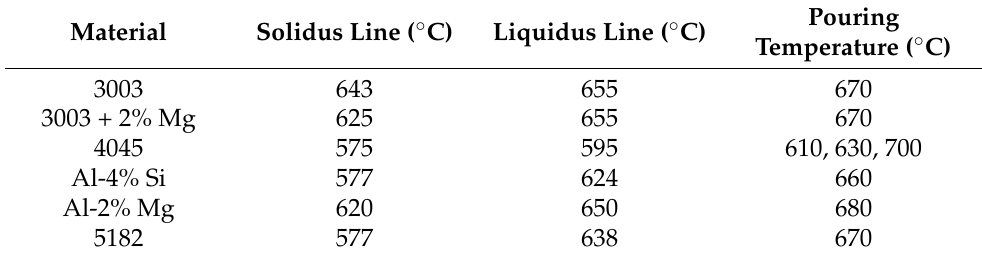
Figure 12. Cross-section of as-cast clad strips. ( a ) 4045/3003/Al-4%Si clad strip, ( b ) 4045/3003/Al-2%Mg clad strip. Table 1. Solidus lines, liquidus lines, and pouring